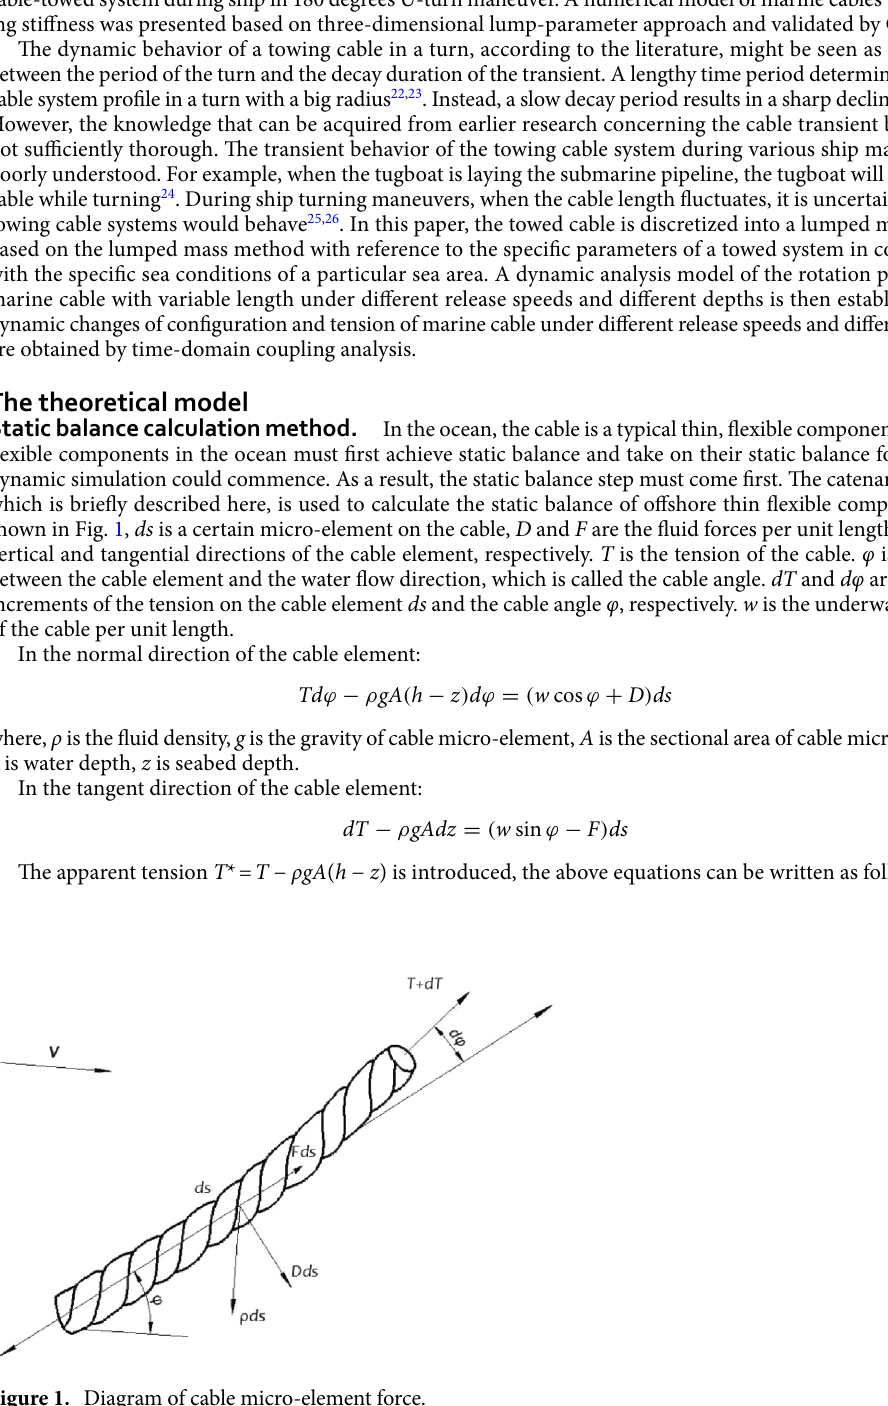
Figure 1. Diagram of cable micro-element